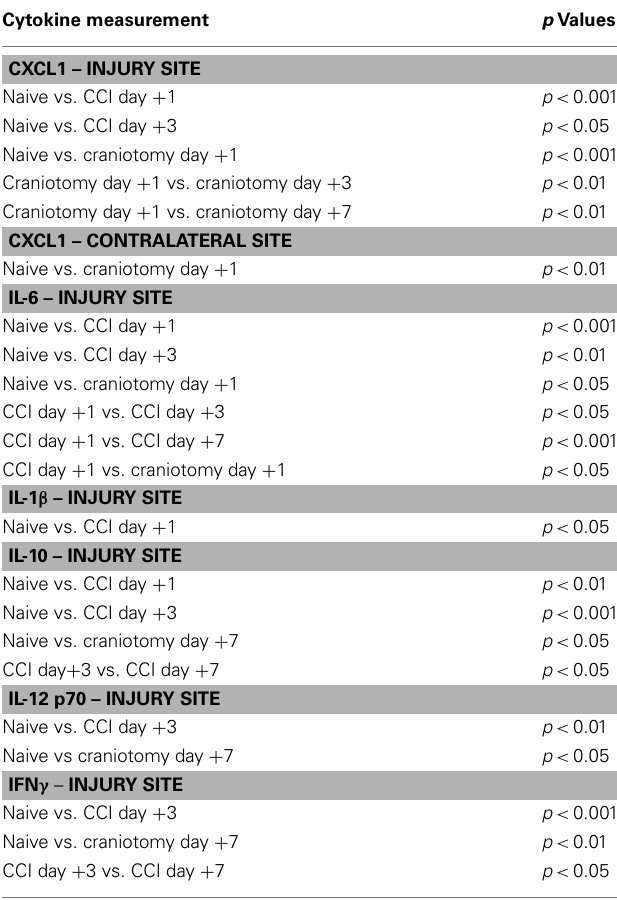
Table 3 | Statistically significant changes in cytokine protein